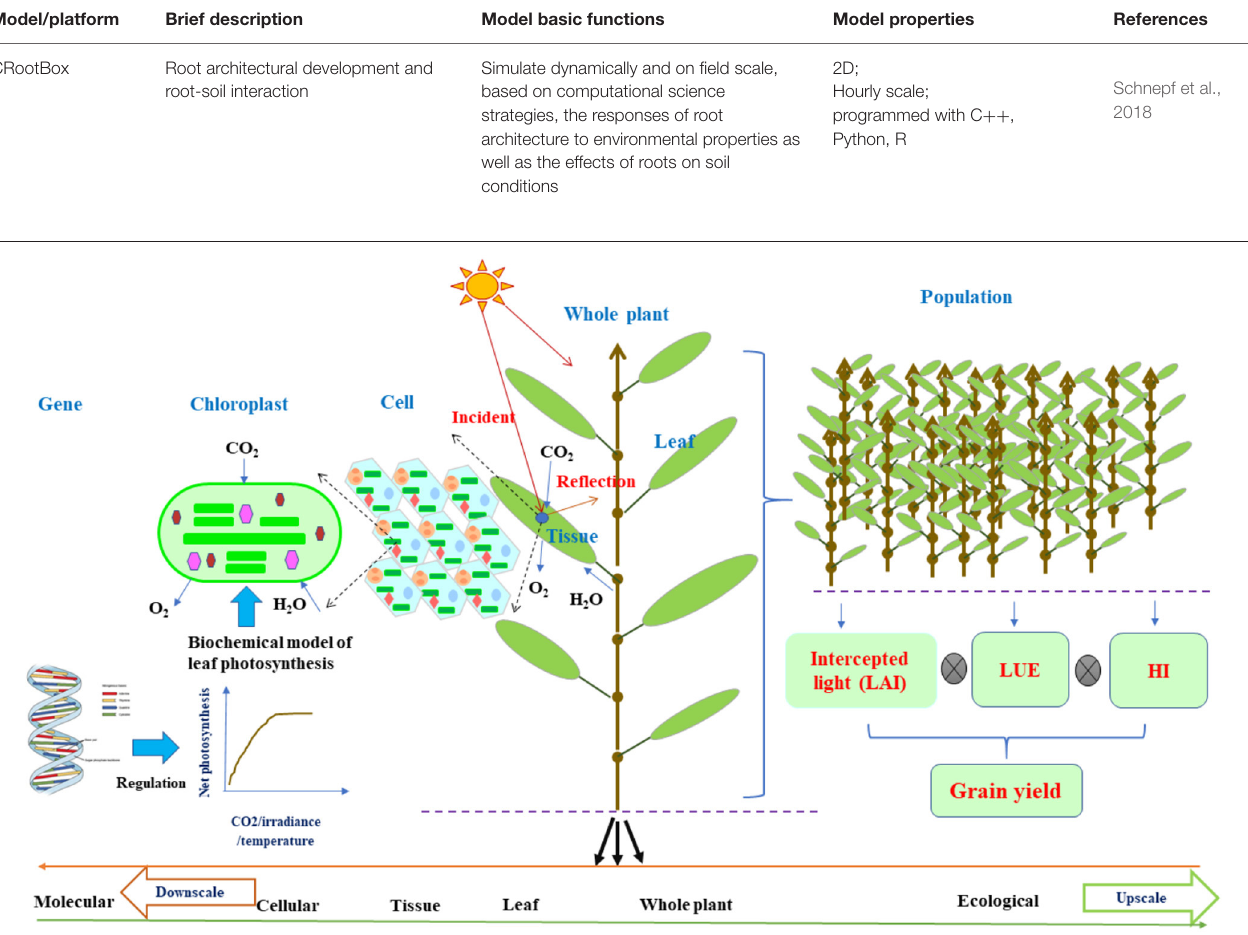
FIGURE 1 | The schematic diagram of plant architecture and functional activities on the basis of individual organs for FSPMs downscaled to the cellular function or upscaled to the ecological function via leaf photosynthesis. Leaf photosynthesis can be decoded as a collection of cellular chloroplast photosynthesis per unit that can adopt leaf C 3 /C 4 biochemical models (Farquhar et al., 1980) regulated by molecular network (Wu et al., 2016); while for field level, the estimation of grain yield from leaf photosynthesis is the intercepted light by the canopy as a function of LAI multiplying with LUE and HI. Leaf photosynthesis acts as a nexus in connecting cellular and molecular level to field level modeling. The curve shows net photosynthetic rate as a function of incident irradiance, CO 2 , H 2 O, and temperature. From left to right, the upscale from molecular to ecological level or vice versa for downscale from right to left. FSPMs, functional–structural plant models; LAI, leaf area index; LUE, light use efficiency; HI, harvest